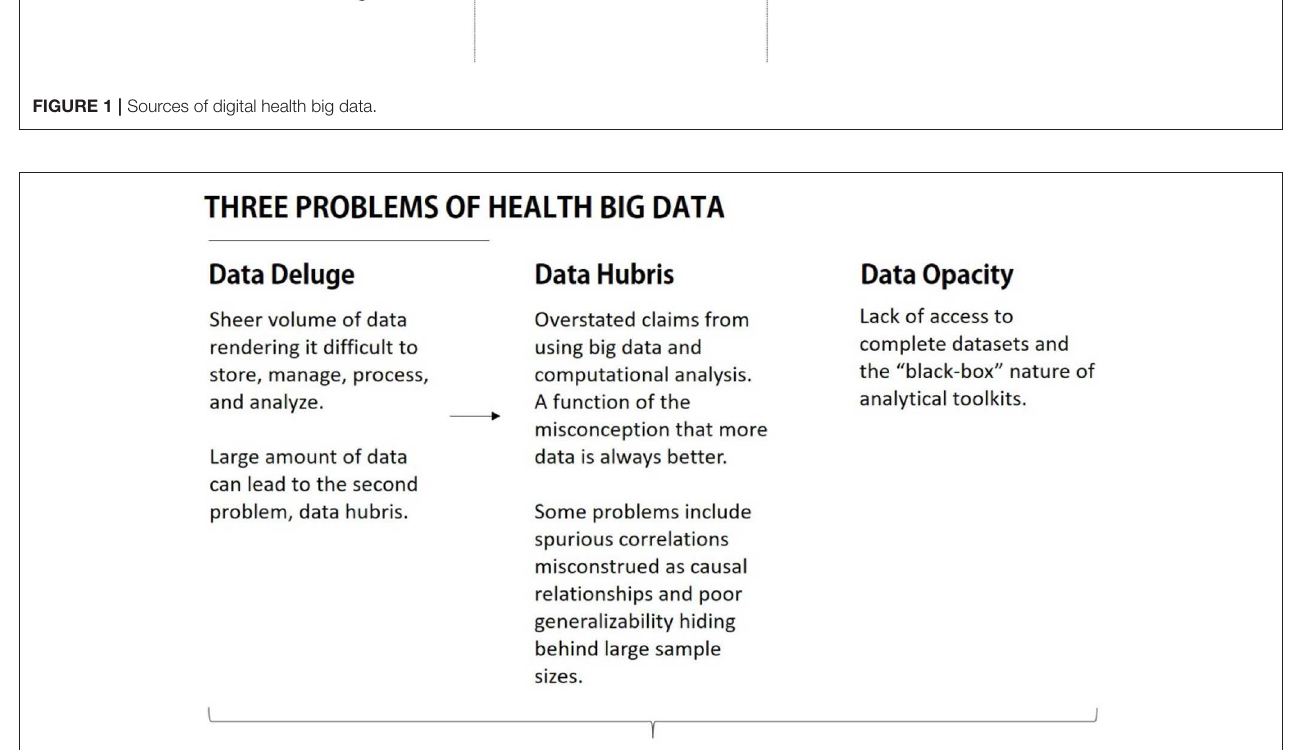
FIGURE 2 | Summary of problems in health big